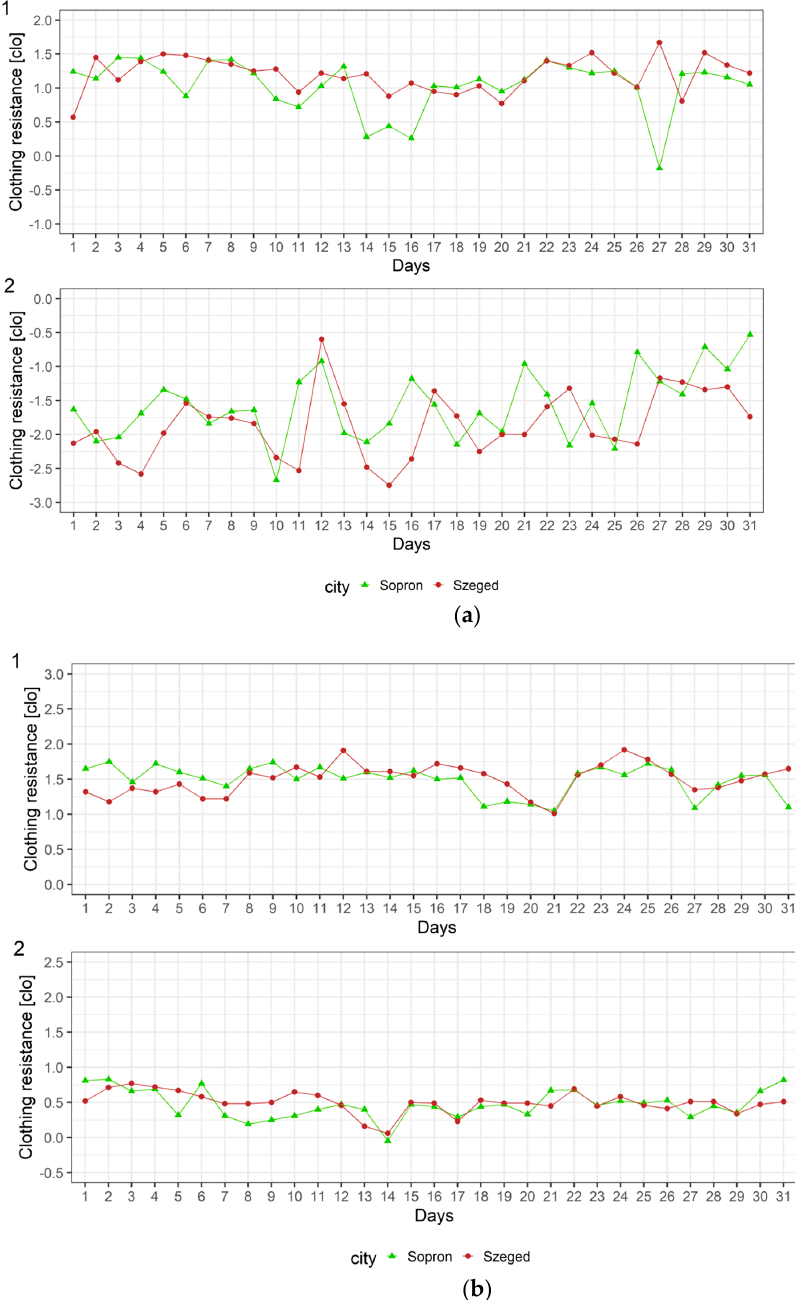
Figure 6. ( a ) Evolution of thermal load at noon (12 UTC) in the cities of Sopron and Szeged over 31-day winter ( 1 ) and summer ( 2 ) season periods for human 5; ( b ). Evolution of thermal load in the morning (4–6 UTC) in the cities of Sopron and Szeged over 31-day winter ( 1 ) and summer ( 2 ) season periods for human 5.